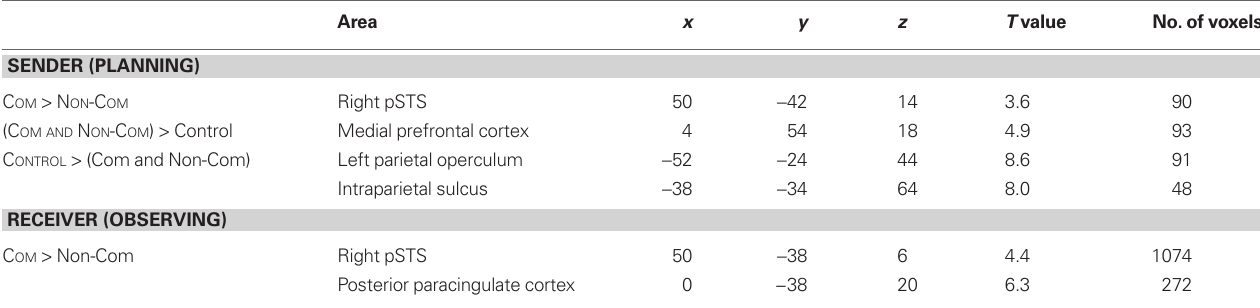
Table 3 | Results of the random effects analysis related to C OMMUNICATIVE (C OM ), N ON -C OMMUNICATIVE (N ON -C OM ) and C ONTROL trials. Area x T value No. of